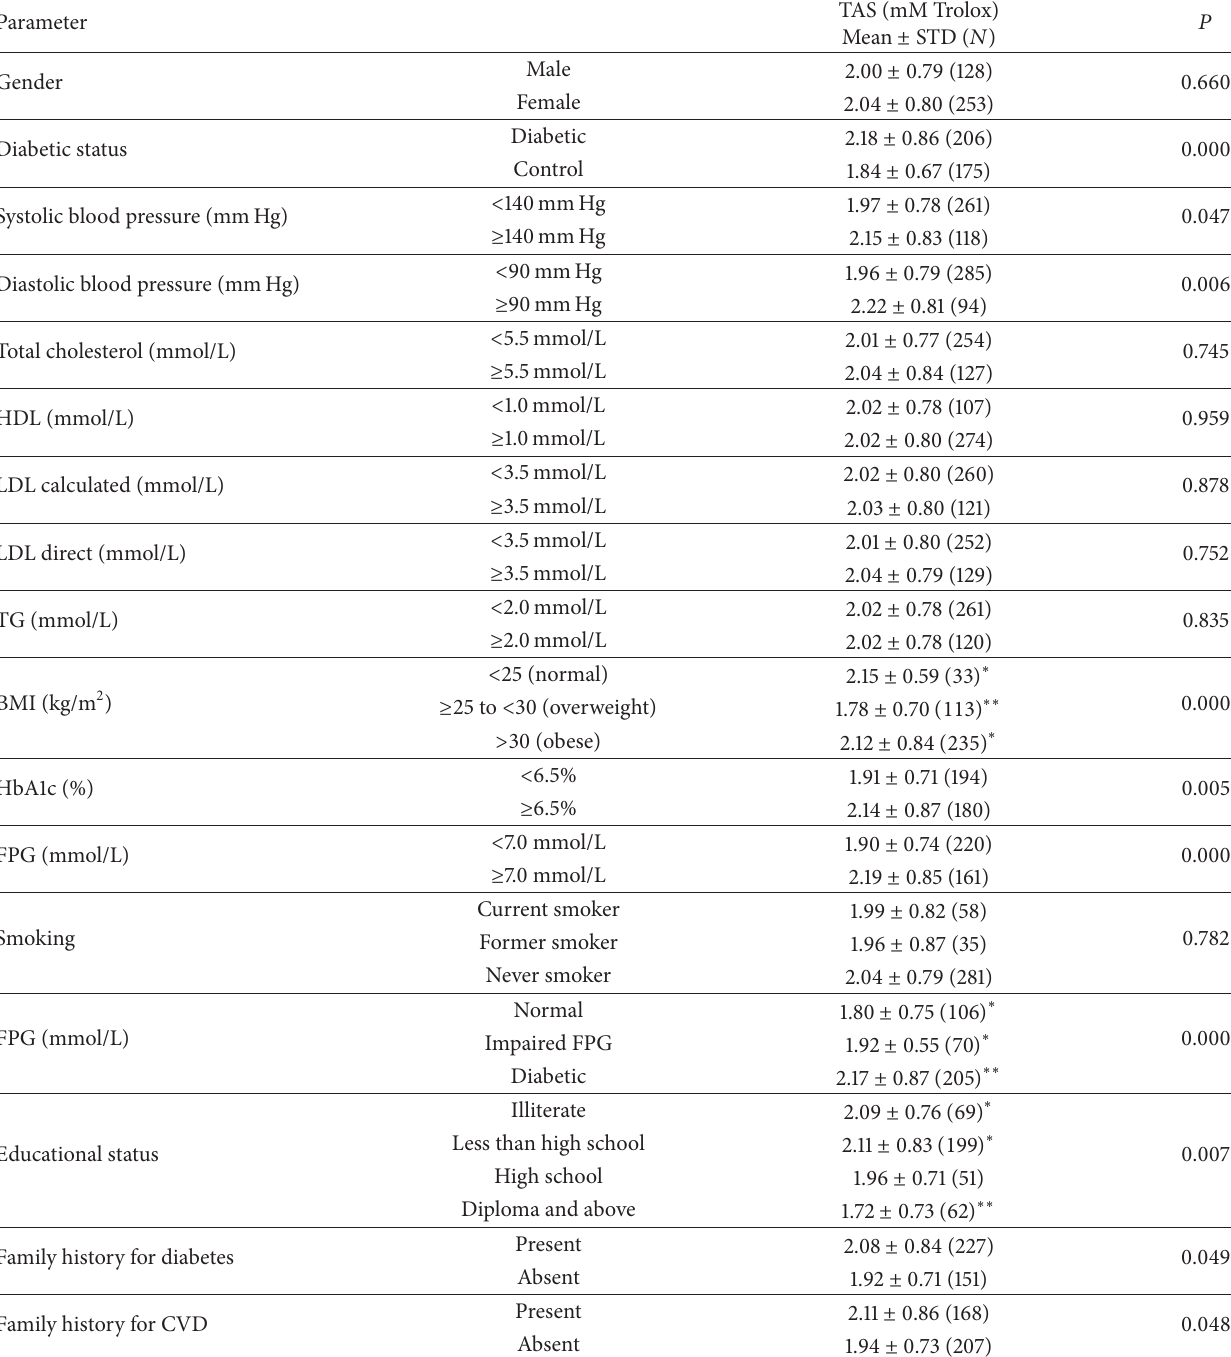
Table 2: Comparison between mean values of total antioxidants status (TAS) with respect to different